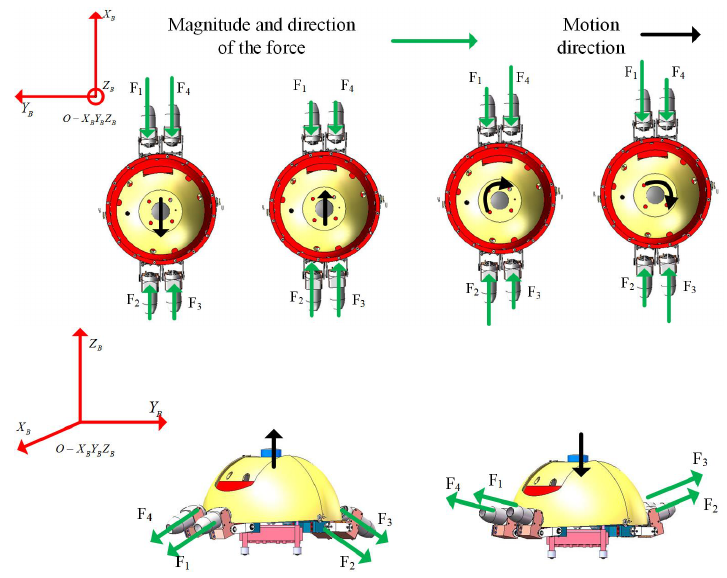
Figure 4. “H”-shaped propulsion